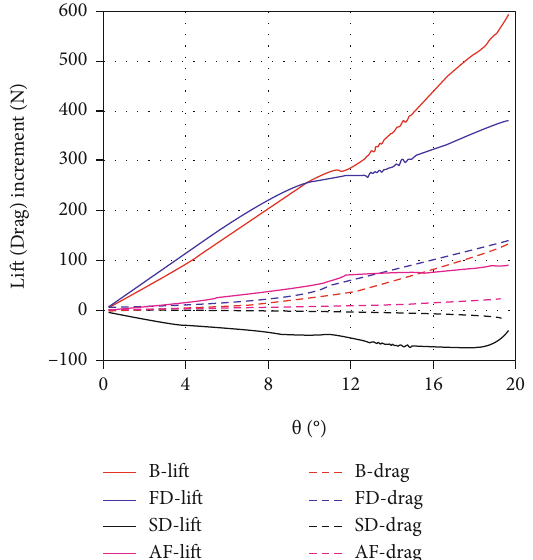
Figure 10: The lift and drag increments in the erection state of the body (B), fi rst dorsal (FD), second dorsal (SD), and anal fi ns (AF) under the quasistatic yaw motion ( ω = 0 : 01 rad/s).